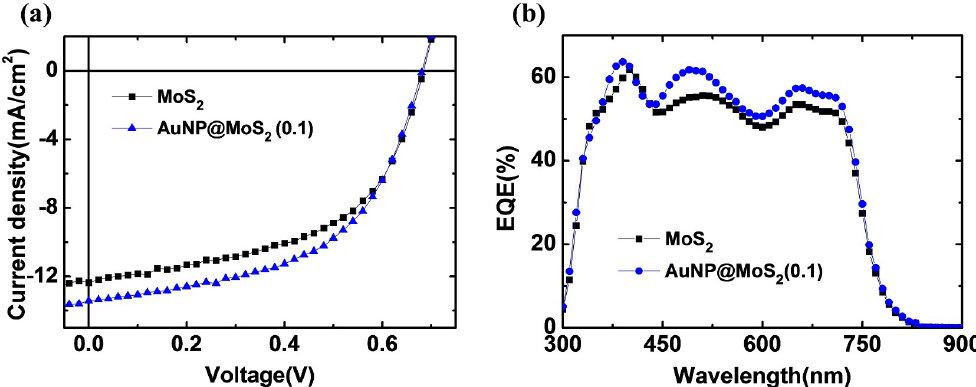
Figure 5. ( a ) J-V curves of the OPVs prepared with various MoS 2